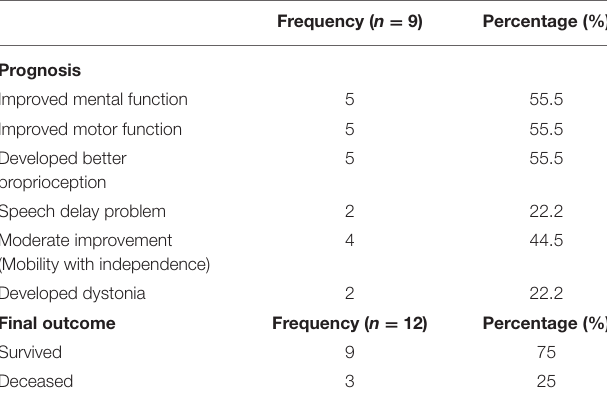
TABLE 5 | Prognosis and final outcomes: n = 12.